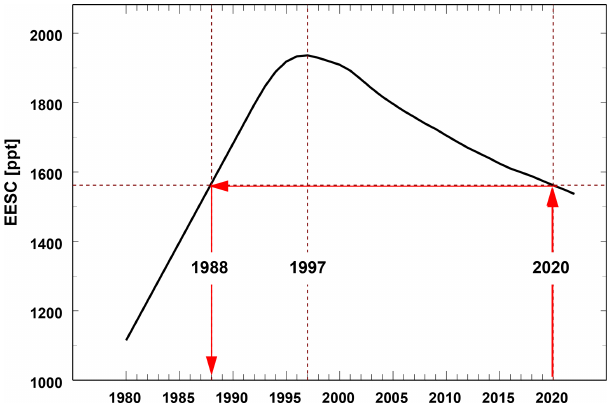
Figure 1. The EESC time series with marked key years: the EESC maximum in 1997 and 1988 when the EESC value was the same as in 2020 (the end of total column ozone data used in the paper) based on the EESC pattern proposed by Montzka et al.